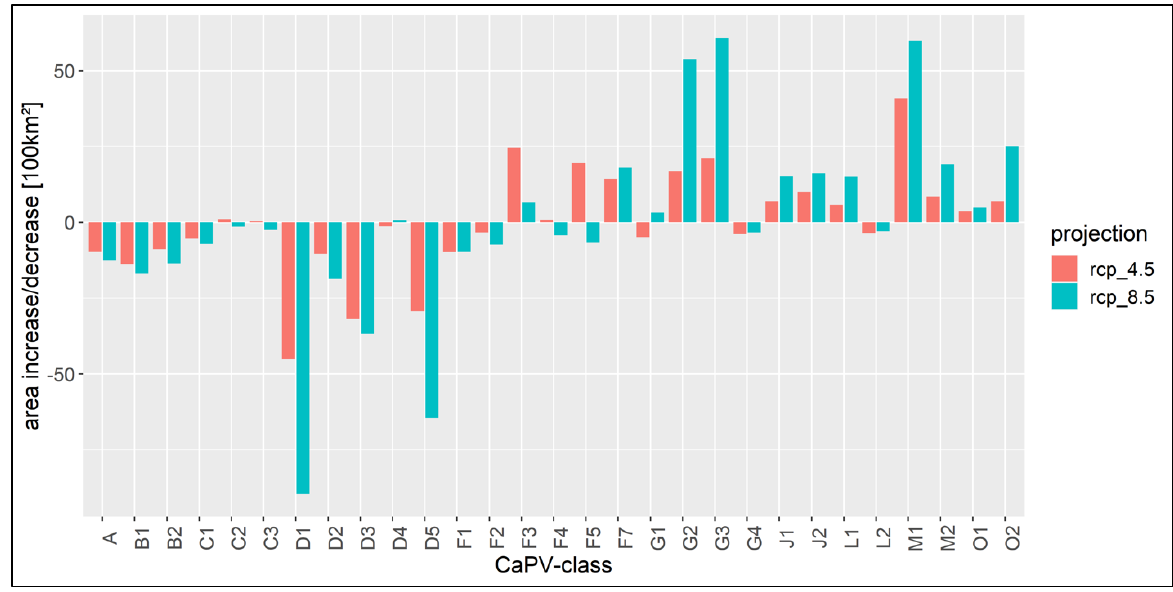
Figure 4. Area changes in potentials (100 km²) of the climate-adapted potential vegetation classes (CaPV class) 'solid bars' until 2070 for RCP 4.5 'red' and RCP 8.5 'blue'.